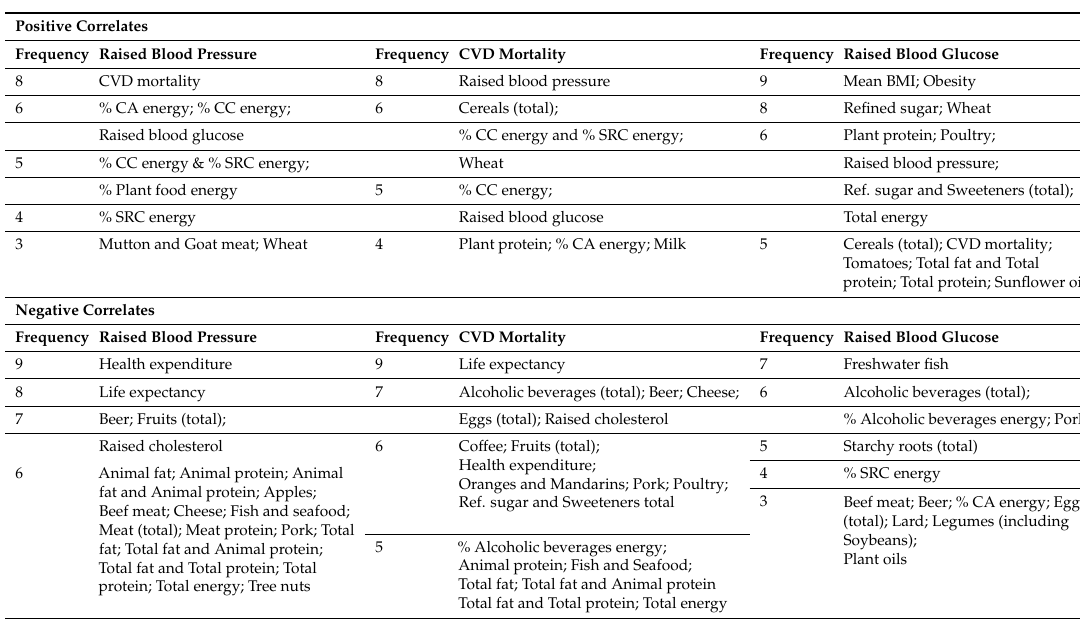
Table 8. Frequencies of significant correlates of CVD indicators ( p < 0.05) across five pre-defined regions in both sexes (see Tables 2 and